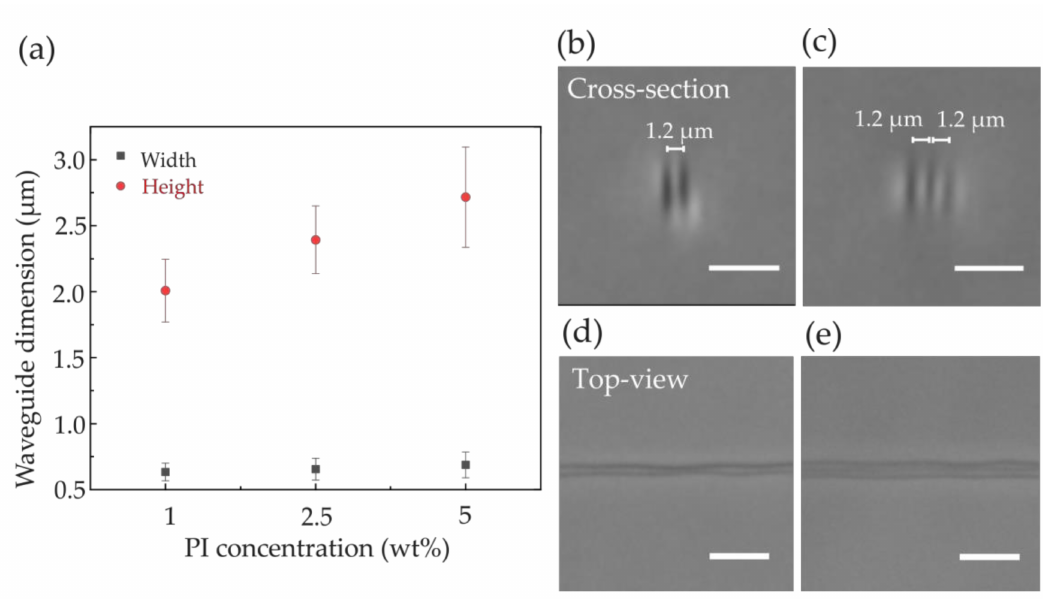
Figure 6. ( a ) Waveguide dimensions as a function of the Irgacure OXE02 concentration into the DVB monomer. The size of the waveguides increases with increasing PI concentration. The isolated, single waveguides were fabricated at an intensity of ~1.78 × 10 12 W / cm 2 and a velocity of 3.2 mm / s. Scale bars measure 5 µ m; error bars indicate the standard deviation from five di ff erent waveguides; cross-sectional view taken in a phase contrast microscope (Nikon IX-71) of a double-cored ( b ) and a triple-cored ( c ) poly-DVB waveguides; top view image of double ( d ) and triple-track ( e ) poly-DVB